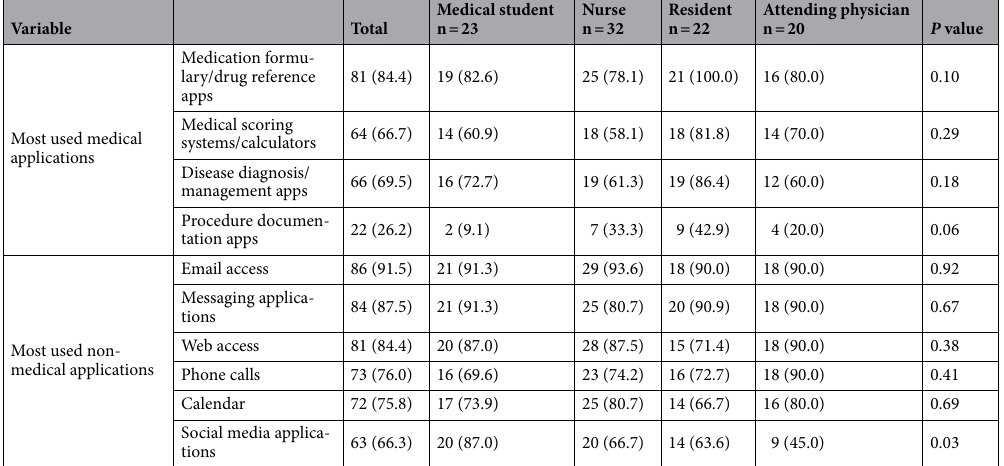
Table 4 shows provider attitudes towards mobile devices, stratified by HCP category. The majority agreed that mobile devices enabled better coordinated care among providers across the hospital (76.5%, 78.1%, 83.3% and 90.0% among attending physicians, nurses, medical students and residents, respectively) and that mobile device use is beneficial to patient care (90.0%, 74.2%, 90.5% and 61.1%, respectively). Nurses registered a higher level of agreement (71.0%) in regard to mobile device use improving ED cohesion and teamwork, compared to medical students, residents and attending physicians (52.6%, 47.4% and 37.5%, respectively). Less than half of the attending physicians felt that mobile device use by providers improves patient safety (44.4%), in compari- son to more than half of the students, nurses and residents (55.6%, 53.3% and 82.4%, respectively). Most of the respondents agreed that mobile device use assisted in quickly resolving personal issues (85.0%, 86.7%, 81.0% and 61.1% among students, nurses, residents and attending physicians, respectively) and that using mobile devices reduces their feeling of stress at work (79.0%, 77.4%, 84.2% and 55.6%, respectively). On the other hand, few respondents agreed with the statement that using mobile devices for non-work related purposes positively